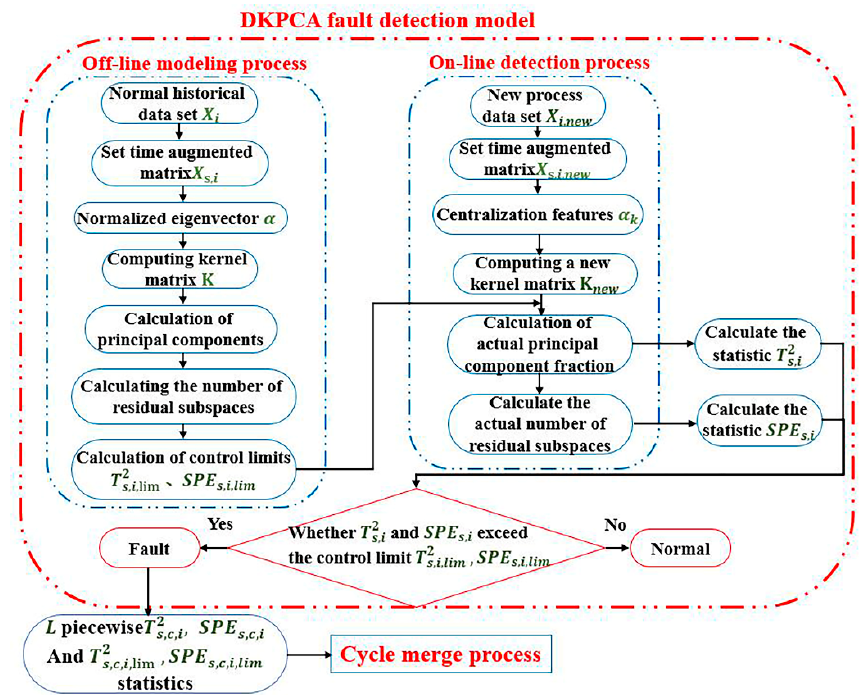
Figure 4. DKPCA model calculation process.